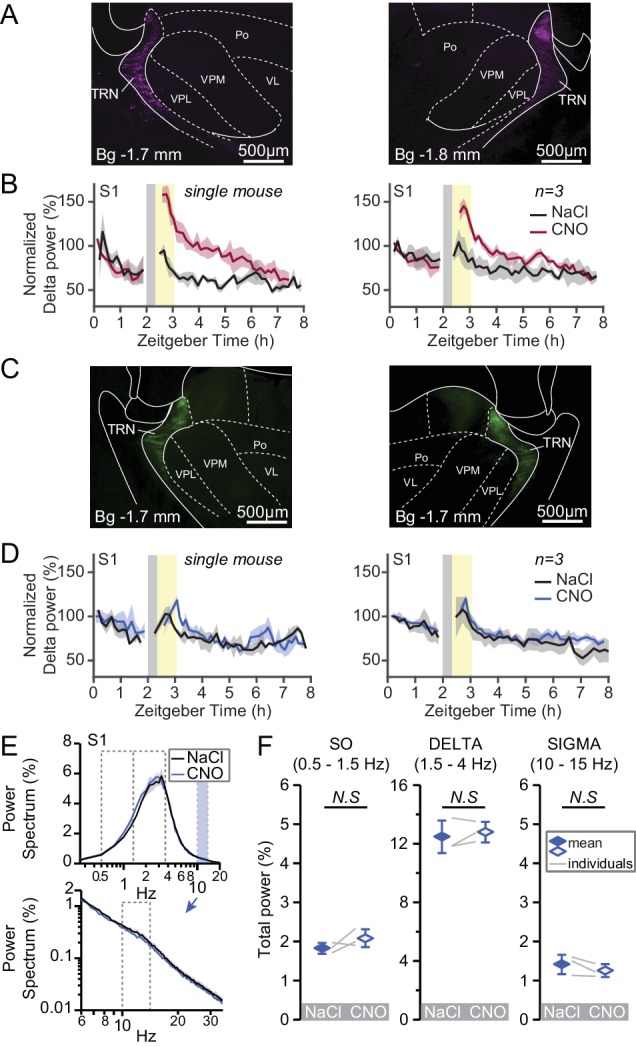
Chemogenetic inhibition of TRN cells acutely increases delta activity in a DREADD-dependent expression.(A) Epifluorescence of coronal brain sections showing bilateral DREADD-mCherry viral expression in the somatosensory TRN sector. (B) Left: mean ±S.E.M. (shaded curve) of S1 delta power dynamics in vivo of NREMS periods after the injection of NaCl or CNO (1 mg/kg) of a representative recording (obtained from same animal as in (A). This animal was injected with NaCl on 2, and with CNO on 3 days. Right: average across animals (n = 3). Shaded vertical areas represent the 20 min after injection (gray) and the 45 min window of maximal effect chosen for analysis (yellow). (C) Epifluorescence of coronal brain sections showing the bilateral expression of a control AAV8 virus in the somatosensory TRN sector as in A. (D) As B for animals injected with a control AAV8. Representative single recording from a mouse that was injected twice for each condition. (E) Mean ±S.E.M. power spectra of the S1-LFPs for NaCl and CNO injections in mice expressing control AAV8 virus during the 20 to 65 min NREMS periods after injection. Expanded portion is shown below in log-log scale to emphasize the sigma band (10–15 Hz). (F) Mean total power for the three frequency bands of interest. Diamonds and error bars show the Mean ±S.E.M across subjects. Gray lines represent individual animals. Statistics are done analogous to Figure 4.